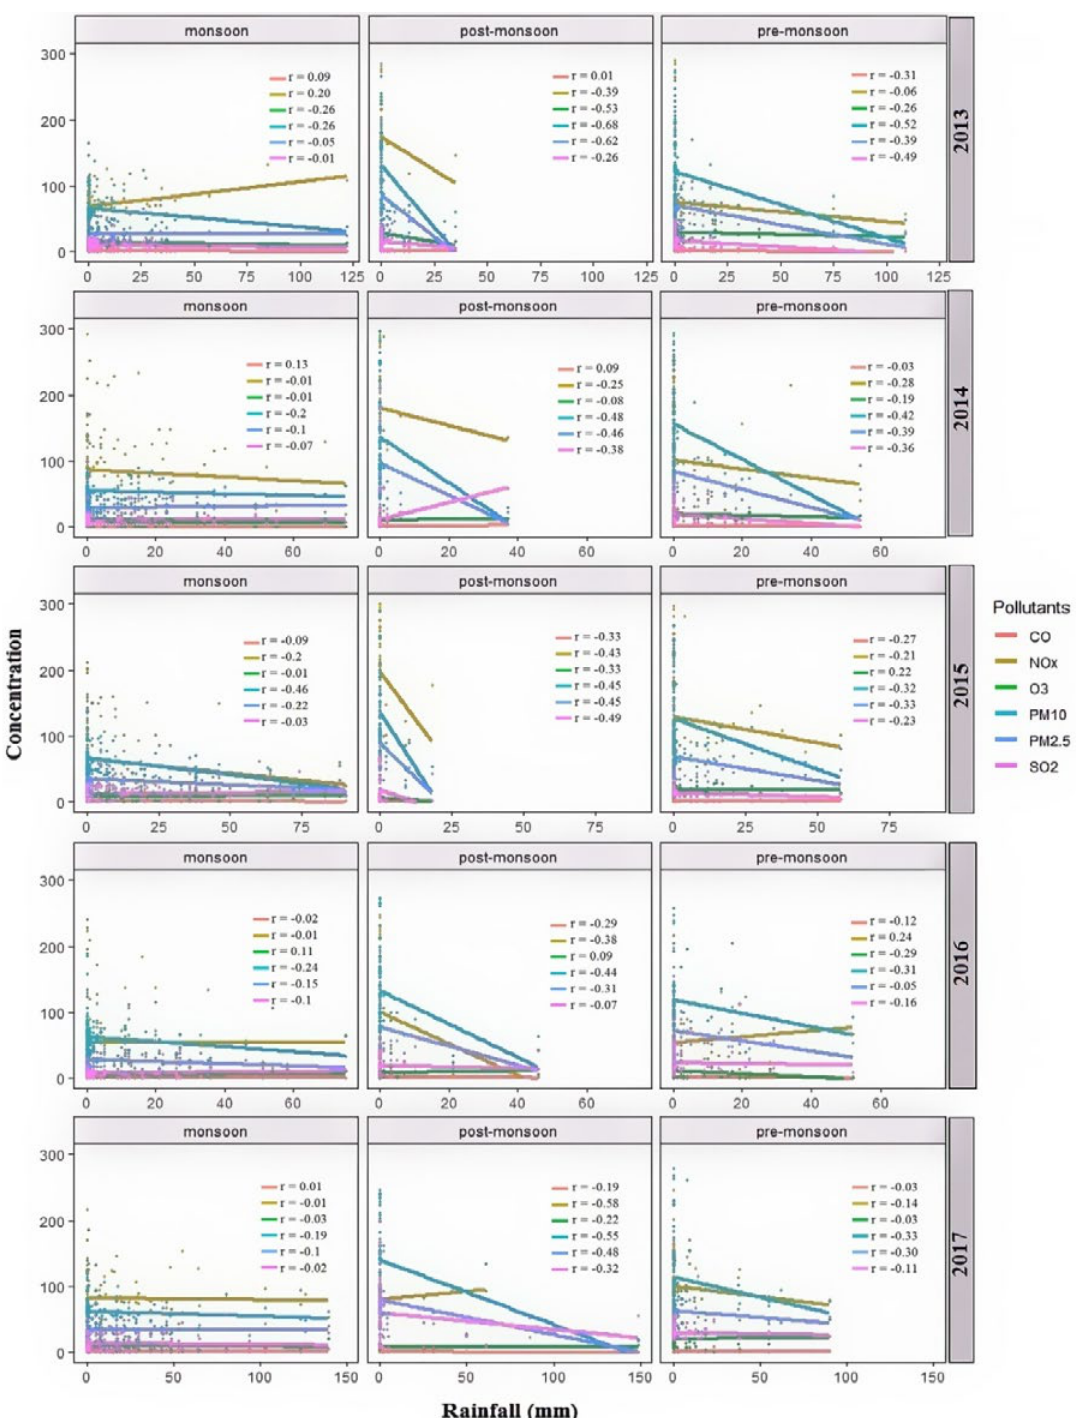
Fig. 7: Line plots showing correlation ( r ) between air pollutants concentration and rainfall during pre ‐ monsoon (March ‐ May), monsoon (June ‐ September) and post ‐ monsoon (October ‐ November) across the years